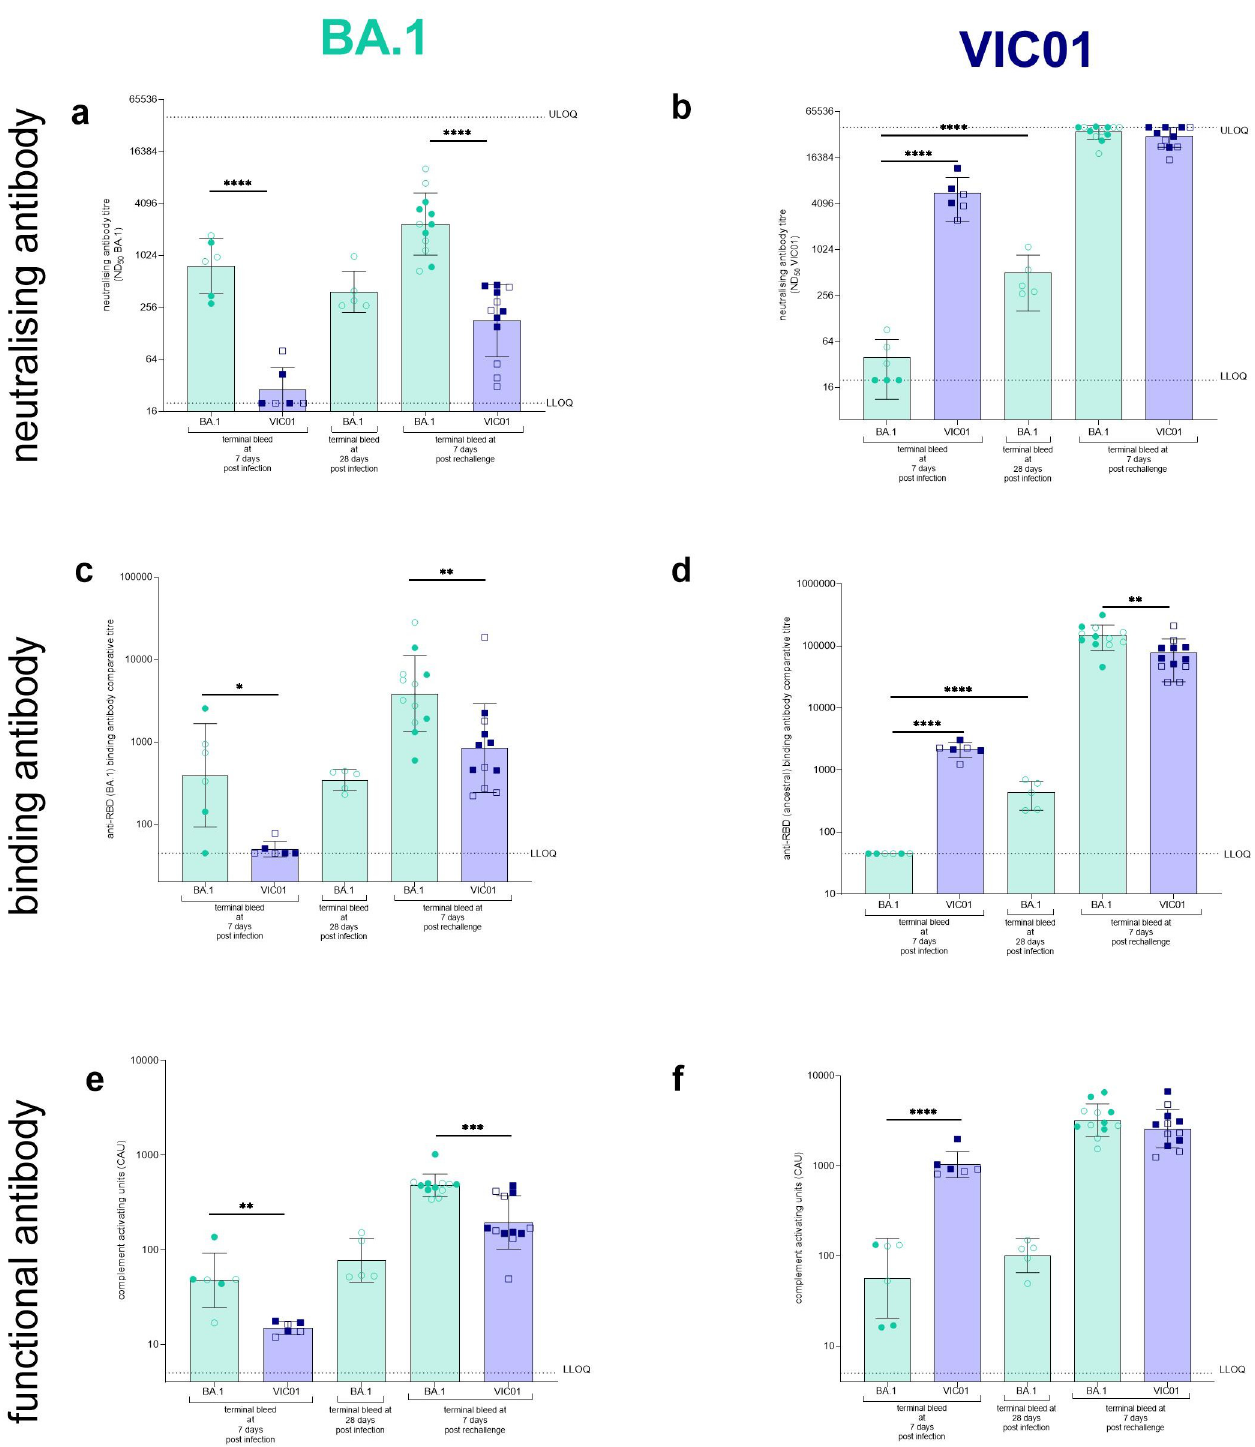
Fig 5. Assessment of humoral responses to VIC01 and BA.1. At scheduled cull points hamsters were exsanguinated and assessed for humoral immune responses against both BA.1 and VIC01. Neutralising antibodies were assessed against ( a ) BA.1 and ( b ) VIC01. Significantly more (P < 0.0001) BA.1 neutralising antibodies were detected in BA.1 rechallenge animals compared to VIC01 rechallenged hamsters. A significantly high ND 50 titre was seen in the homologous groups for VIC01 (P < 0.0001) and BA.1 (P < 0.0001) when compared against the heterologous singularly infected group. A significant increase (P < 0.0001) was seen between VIC01 neutralising antibodies at day 7 and day 28 post BA.1 infection. No difference was detected for BA.1 neutralising